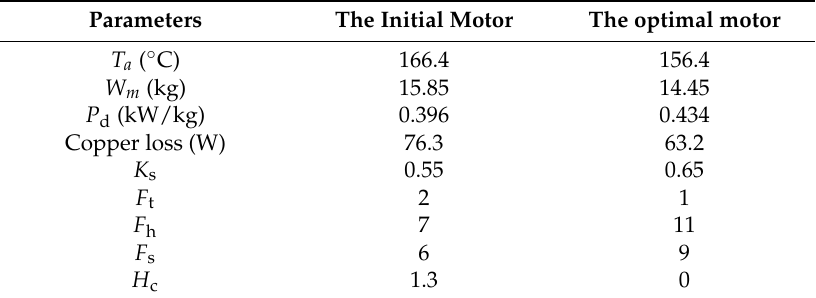
Table 13. Comparison of the results of the initial motor and the optimal motor.